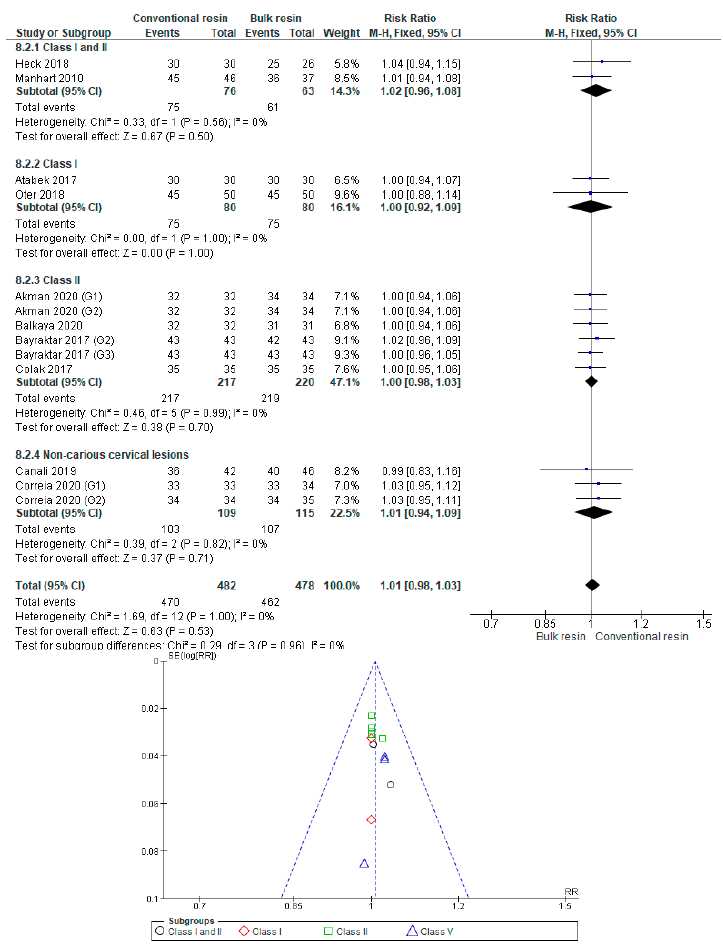
Figure A35. Proper Anatomical Form: Conventional Resin versus Bulk Resin Covered with Conventional Resin According to Type of Restoration.